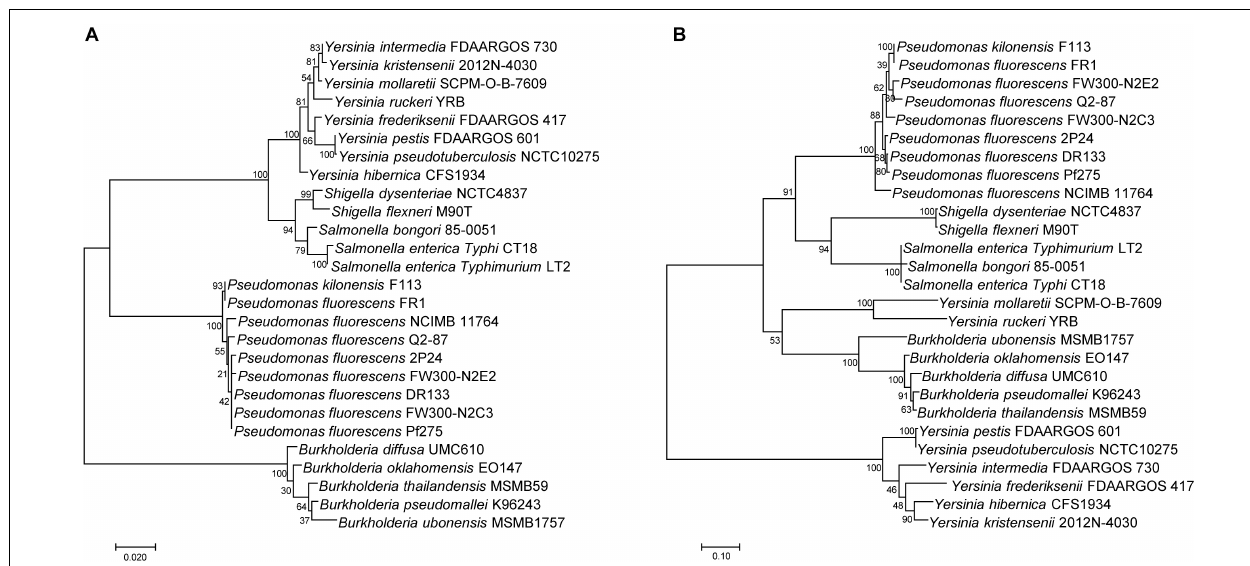
FIGURE 2 | Phylogenetic analysis of SPI-1 T3SS gene clusters of the P. fluorescens group. (A) A distance tree was calculated from 16S rRNA homologs by using the Maximum Likelihood method based on the Tamura-Nei model. (B) A distance tree was calculated from InvA homologs by using the Maximum Likelihood method based on the JTT matrix-based model.